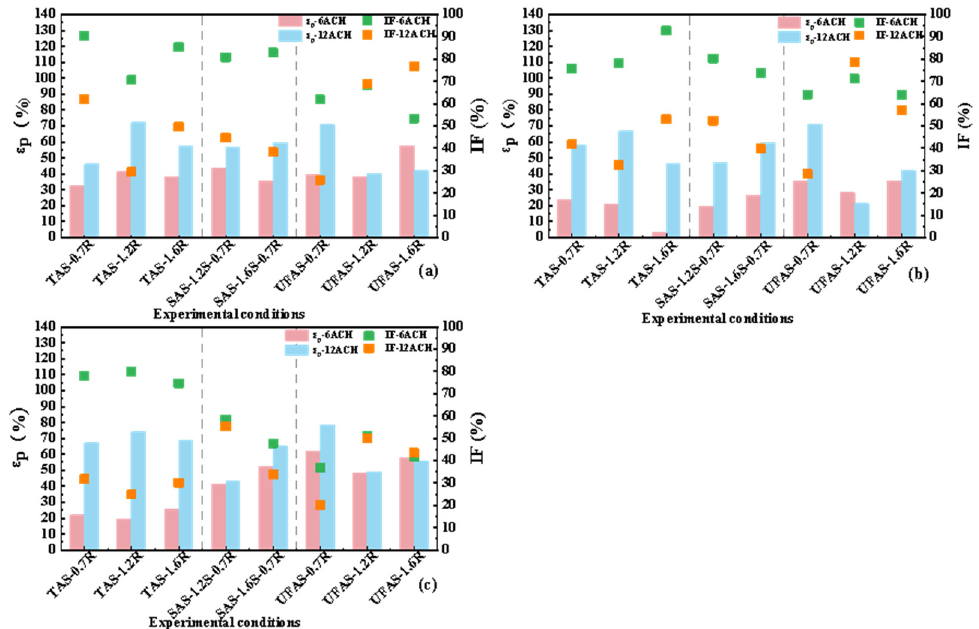
Figure 8. Inhalation fraction index IF and personal exposure effectiveness of healthcare workers at different distances between healthcare workers and patients. ( a ), ( b ) and ( c ) represent the distances between the medical staff and the patient of 0.5 m, 1.0 m and 1.5 m, respectively.